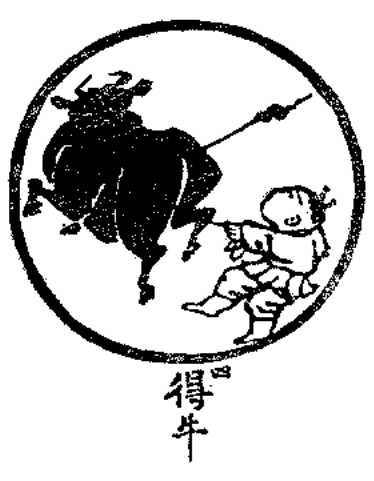
Figure 4. Wrestling with the